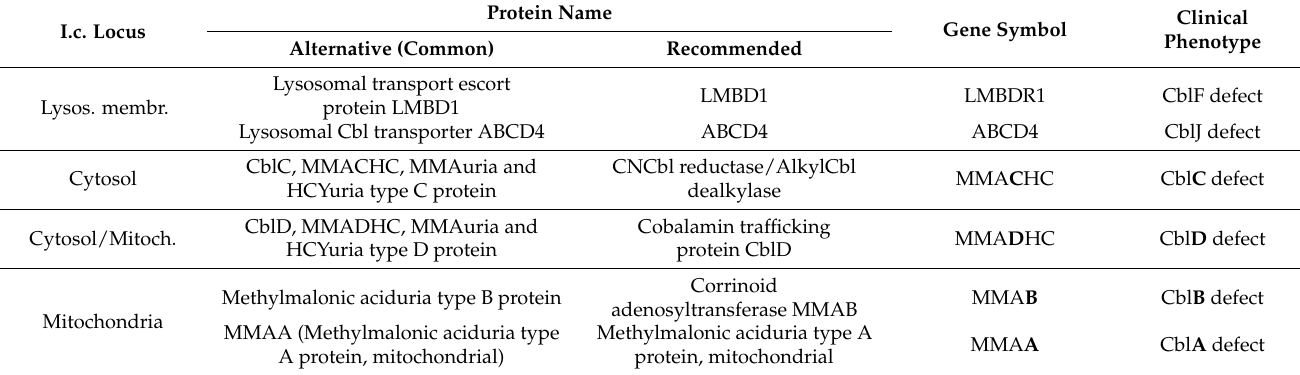
Table 1. Inherited Cbl deficiencies. For current protein nomenclature we refer to UniProt database [8]. Letters in the gene symbol referring to the certain letter in the disease name are marked with bold in case of Cbl defects: CblA, CblB, CblC, and CblD. HCYuria homocystinuria; I.c. intracellular;